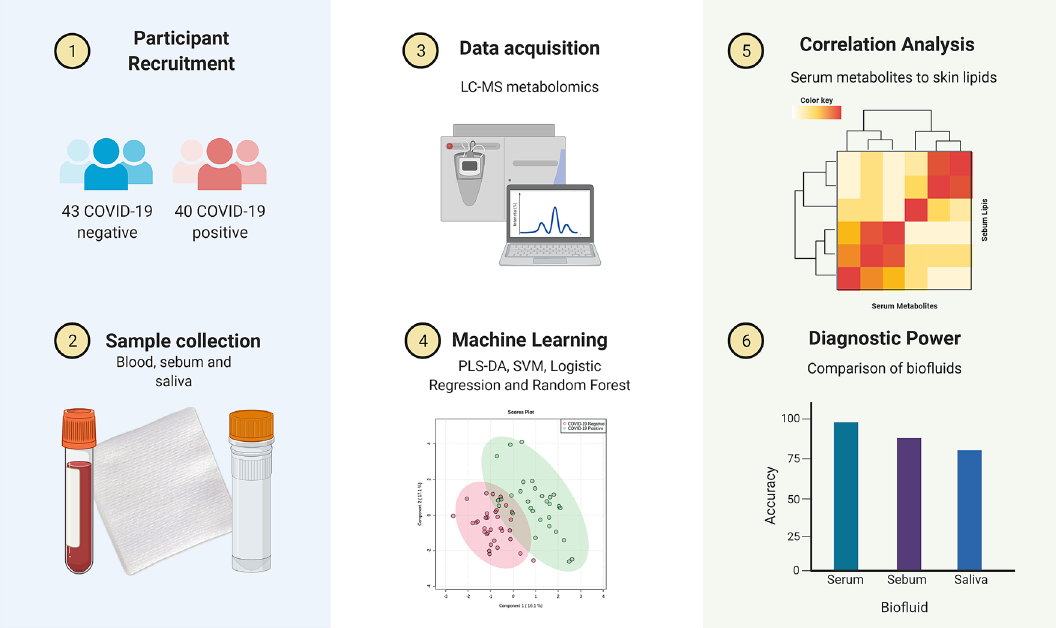
Figure 1. Integrated metabolomics for discovery and validation of COVID-19 biomarkers, created with